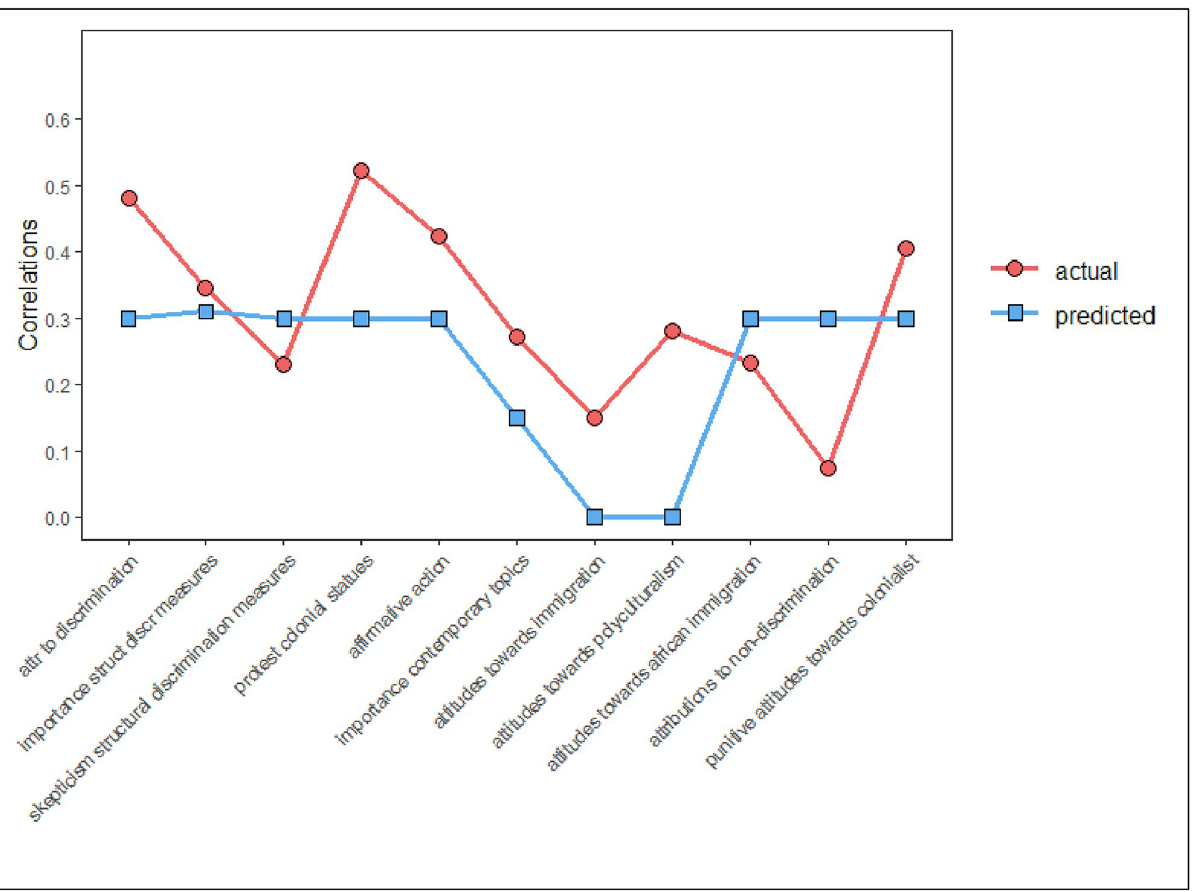
Fig 1. Comparison of actual (red line) and observed (blue line) canonical correlations between AWB and sets of items sharing an underlying theme.